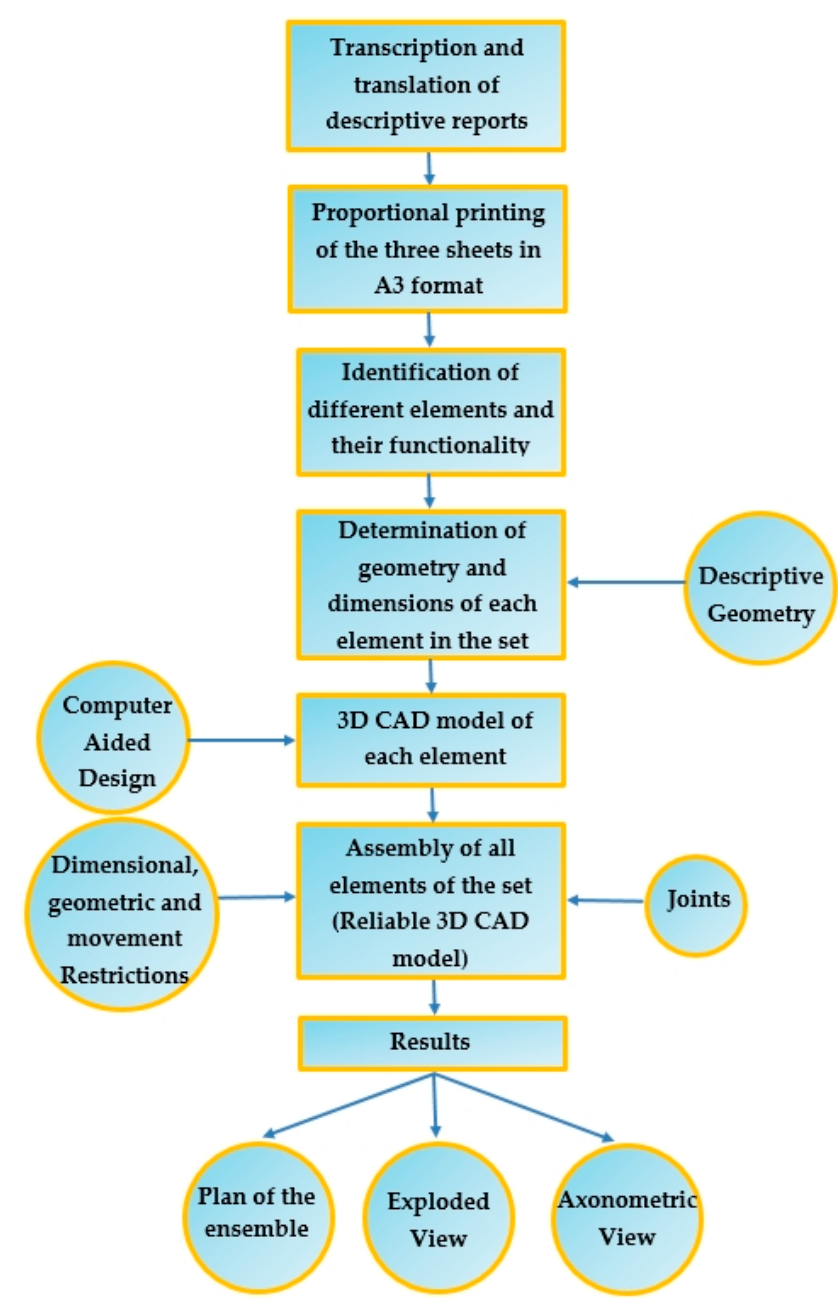
Figure 4. Summative flowchart of the methodology followed in the 3D modeling process.